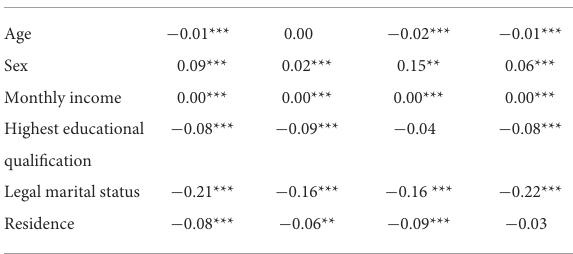
TABLE 2 The estimates ( b ) of linear models trained based on demographic